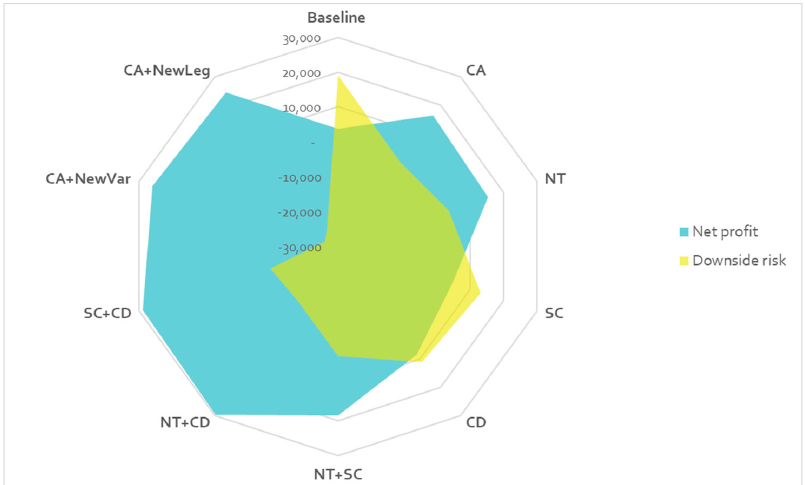
Figure 4. Risk return profile (scale shown in MXN pa) of the baseline and nine innovation scenarios measured in terms of average net profit and downside risk (CVar0.1) over the 10-year period analysed (2011–2020) for the representative farm (T6) in southern Guanajuato. For illustration purposes, downside risk is represented similarly to net profit (e.g., high values = high profit/risk, low values = low profit/risk).